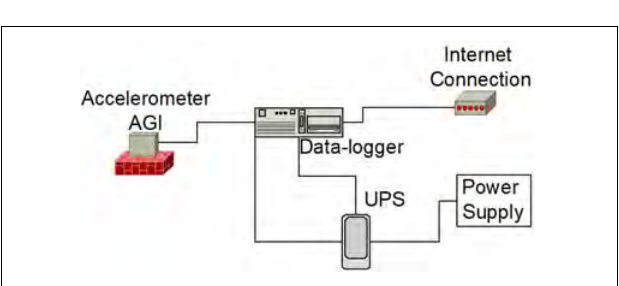
FIGURE 3 | Simplified schematic of an OS–IS station. The UPS (Uninterruptible Power Supply) improves the reliability of the system. All instrumentation is installed indoor, sheltered from the environment (rain, humidity, dust, etc.). One OS–IS station might also include a weather station and a GPS receiver for weather monitoring and precise